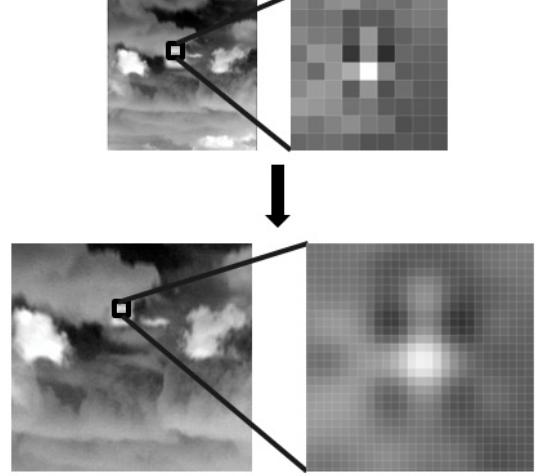
Figure 4. Expanded target pixels.